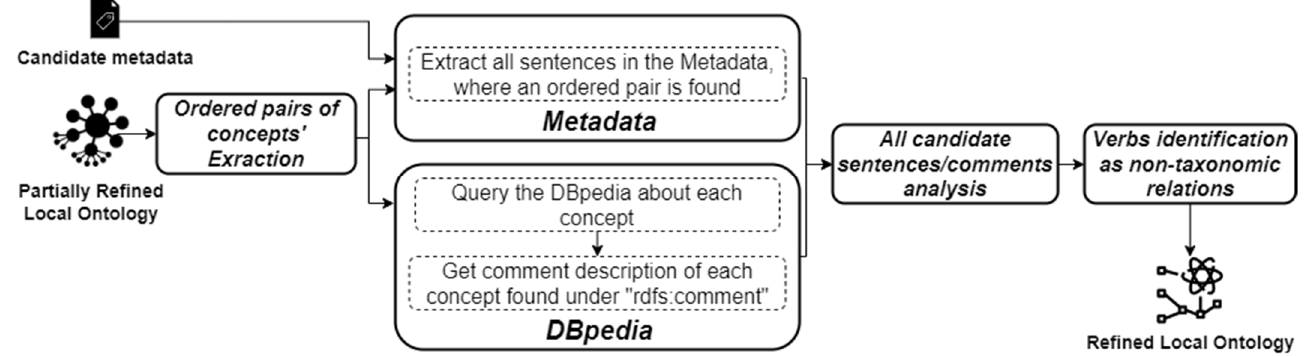
Figure 4. Non-taxonomic relation refinement method.